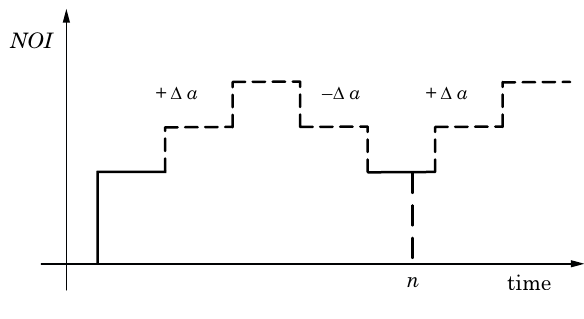
fig. 3. Direct capitalization based on cyclical capitalization (formula 8)